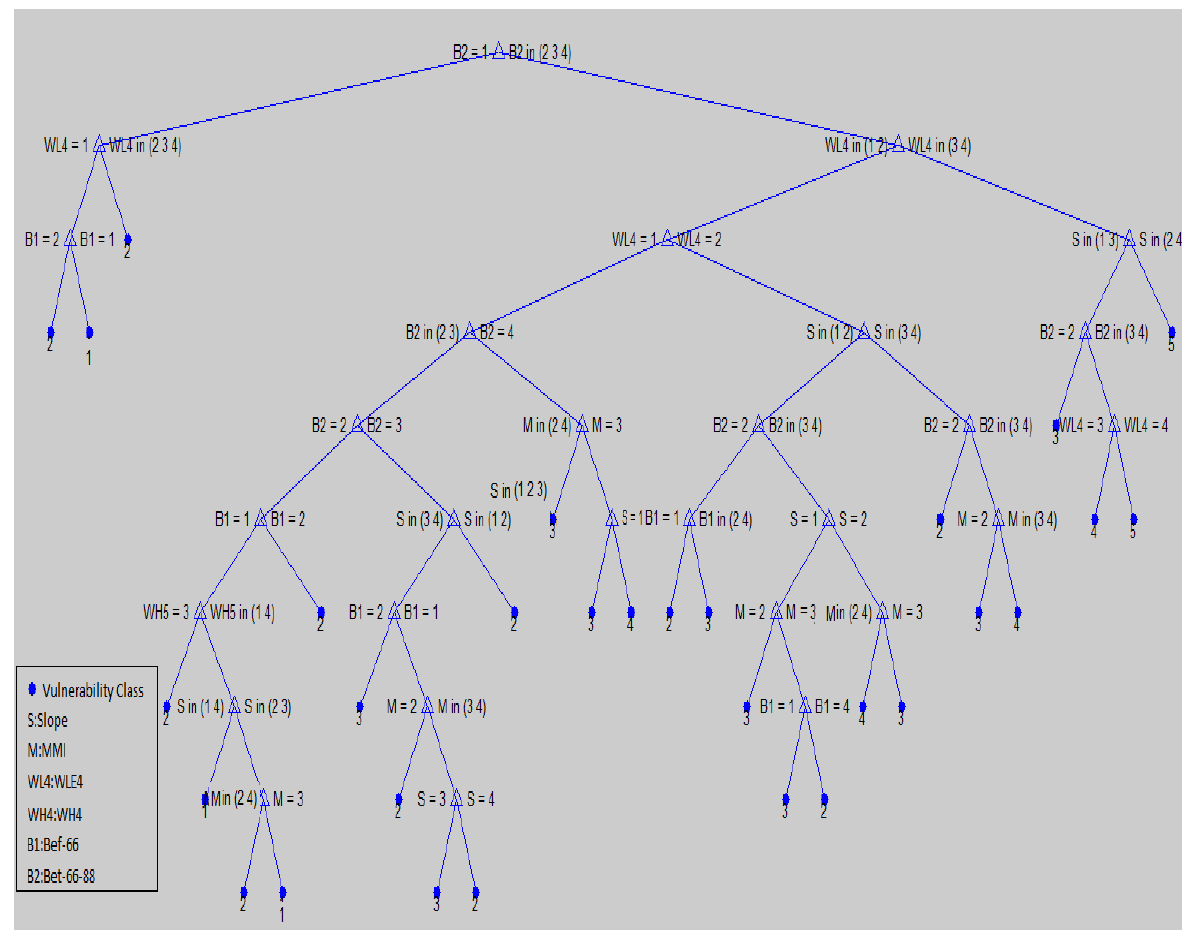
Figure 4. Decision tree of the extracted rules showing rule elements and resulting classes in a tree